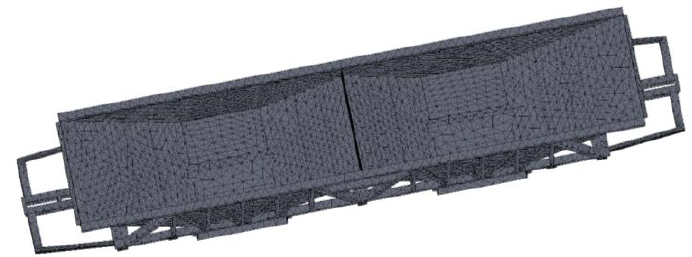
Figure 5. Finite element model of the hopper wagon.